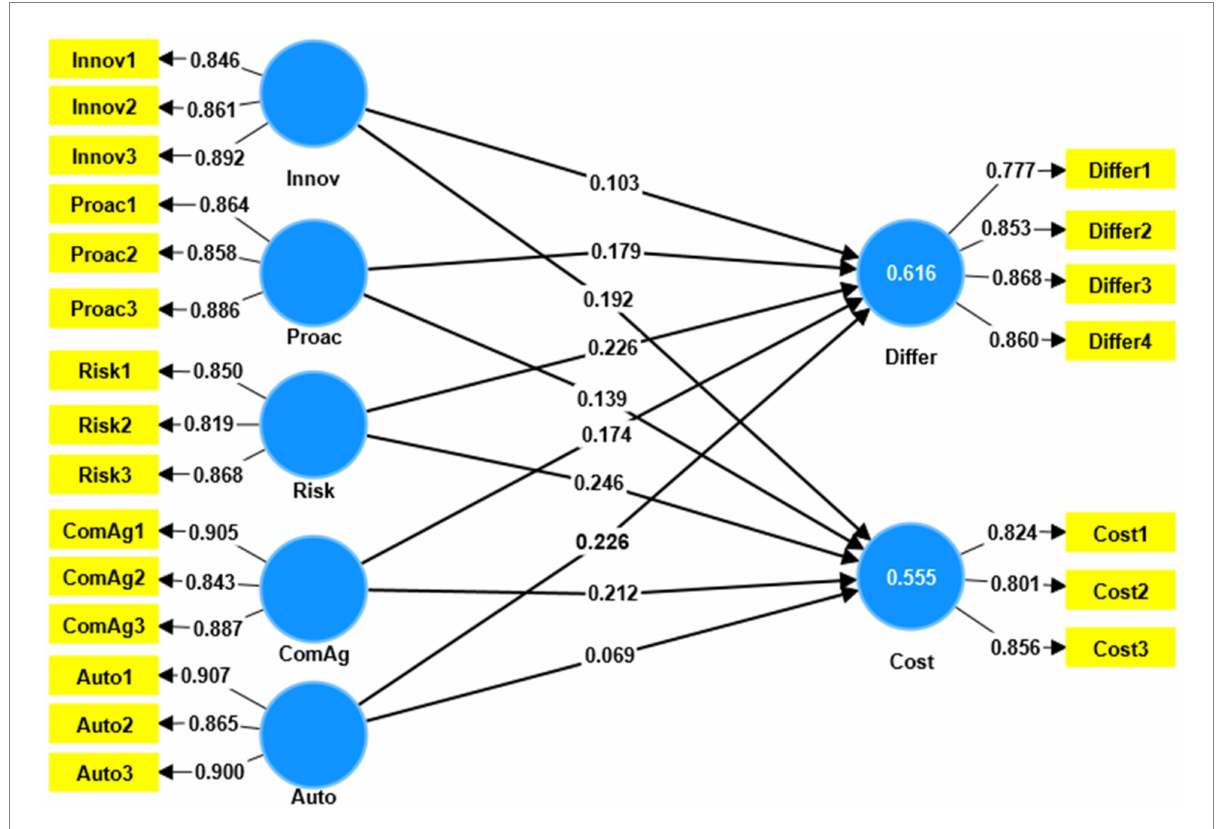
FIGURE 2 Partial least square SEM model.